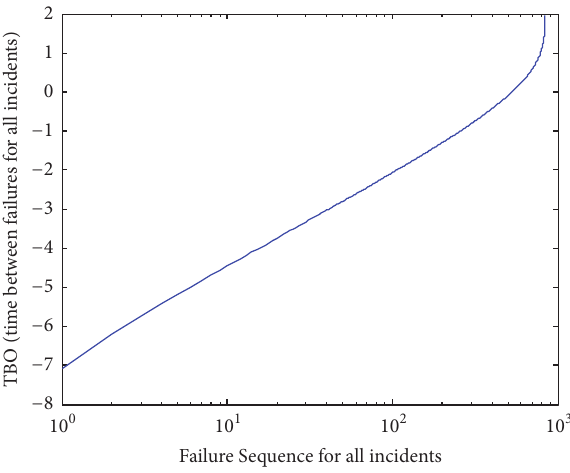
Figure 5: Weibull paper for all incident 2010 to